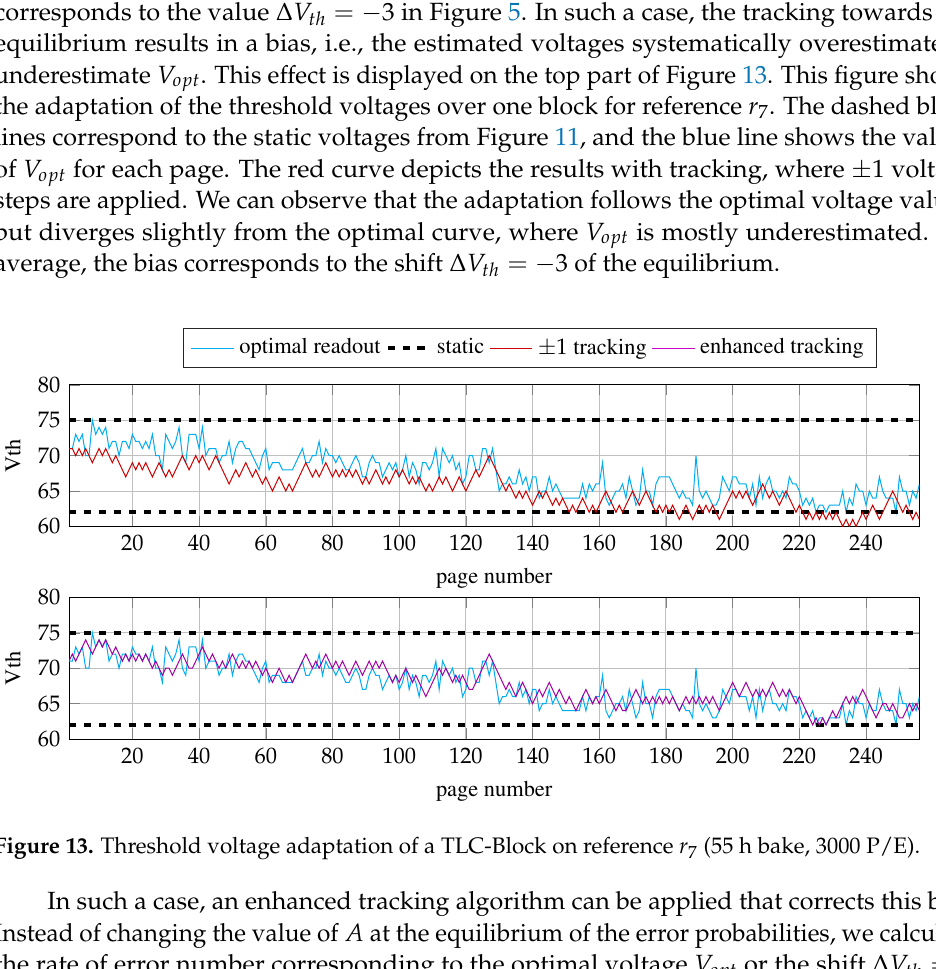
Figure 13. Threshold voltage adaptation of a TLC-Block on reference r 7 (55h bake, 3000